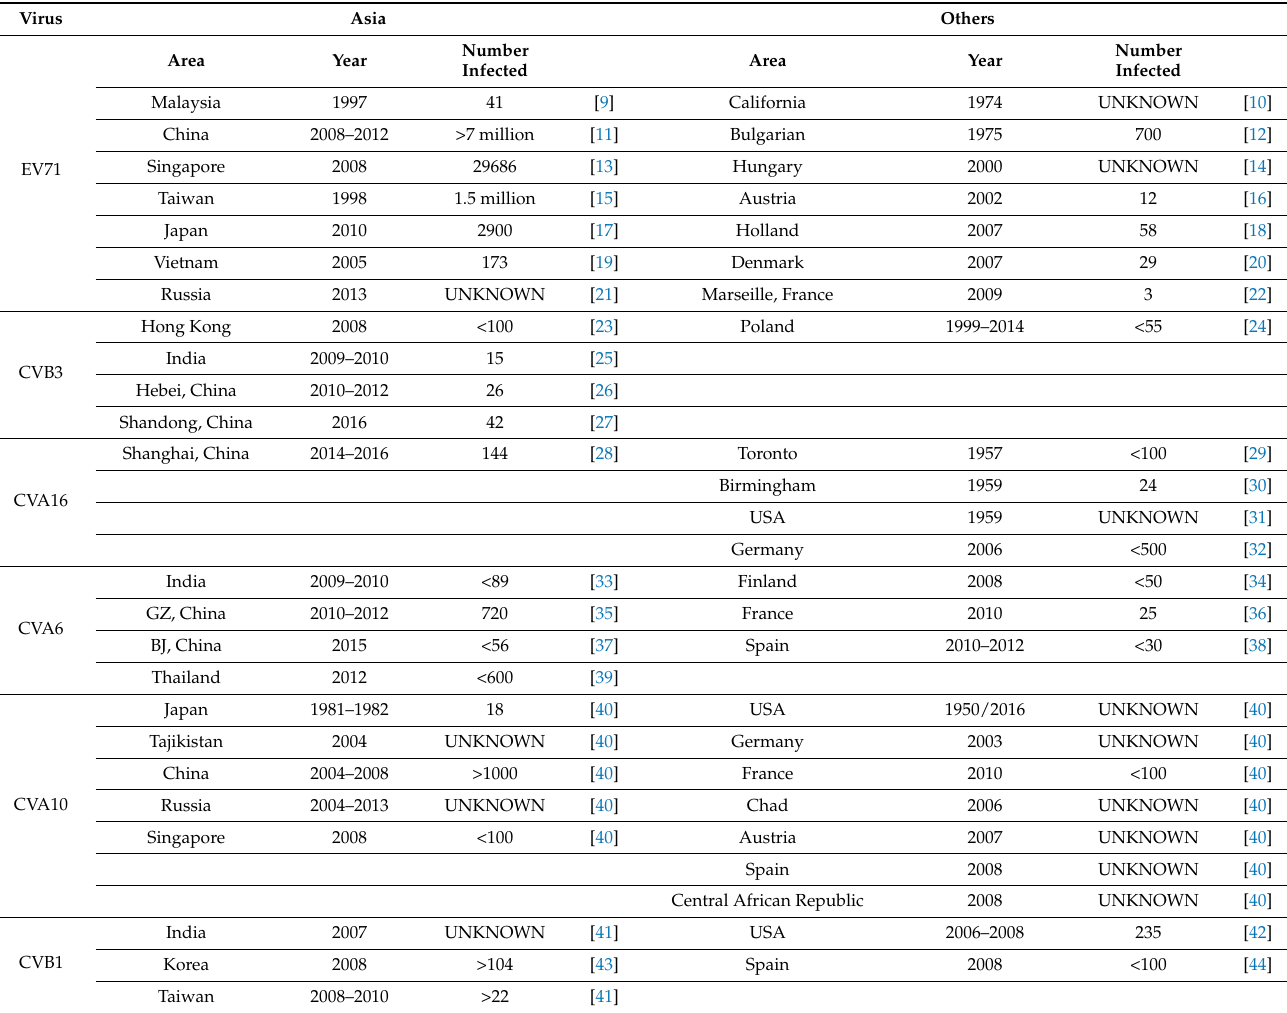
Table 1. Major outbreaks of HFMD and their